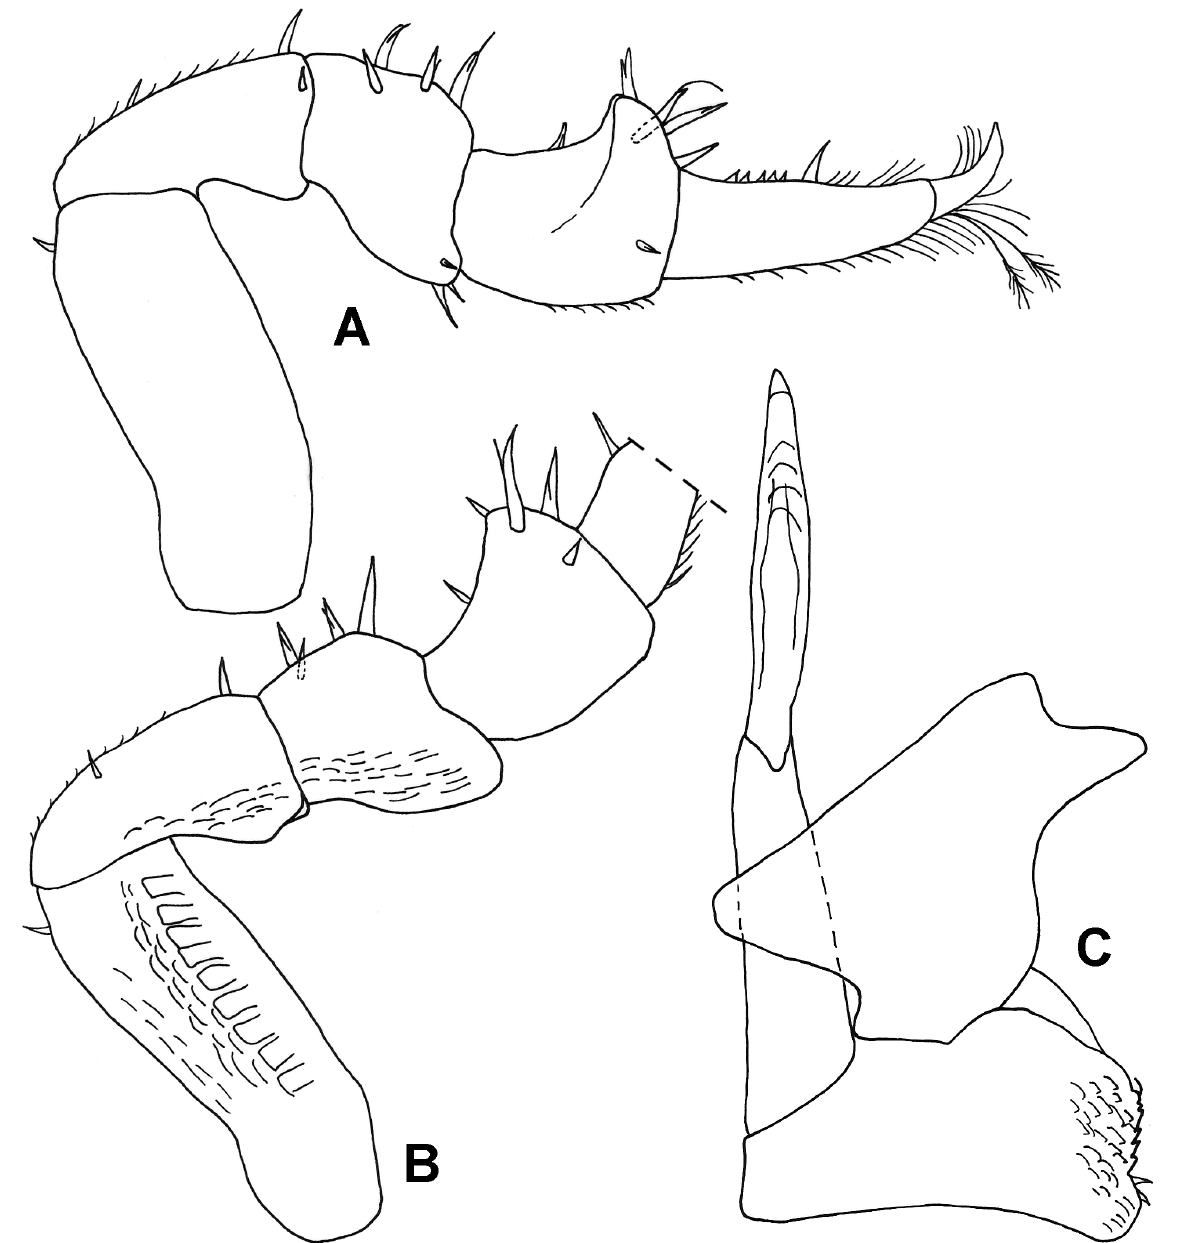
Fig. 22. Moserius inexpectatus Reboleira & Taiti sp. nov. from Gruta do Almonda, Estremenho, Estremoz- Cano Massif, paratype, ♂. A . Pereopod 7, caudal view. B . Pereopod 7, rostral view. C . Pleopod